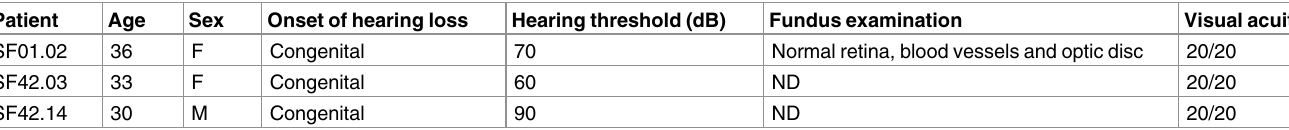
Table 1. Clinical characteristics of patients SF01.02, SF42.03 and